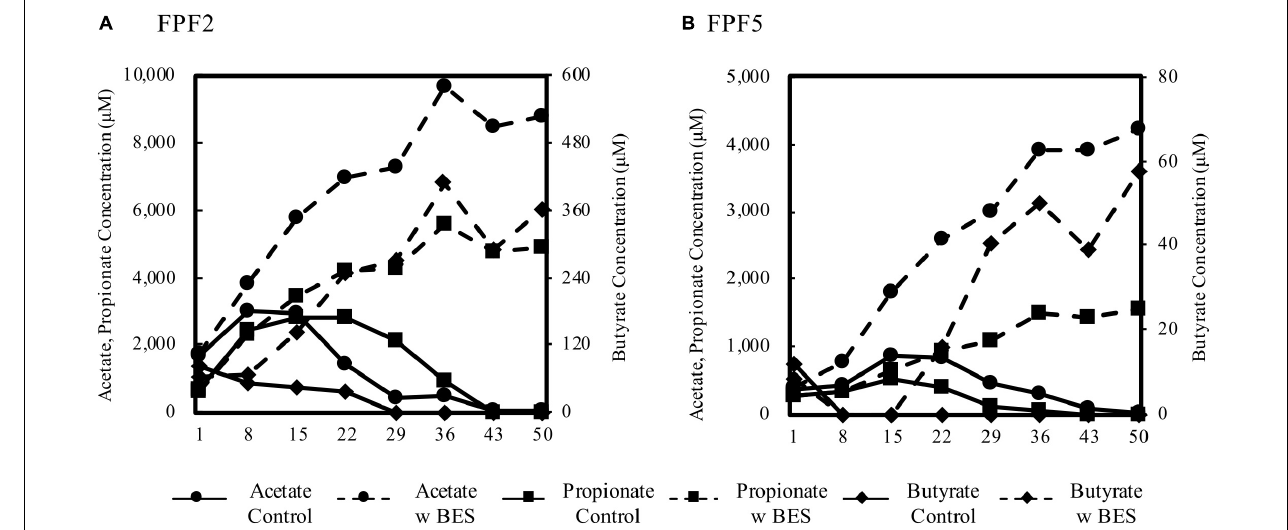
FIGURE 4 | Concentration of acetate, propionate, and butyrate over 50 days in peat slurry incubations from FPF2 (A) and FPF5 (B) . Solid lines represent no-amendment controls and dashed lined represent incubations to which BES was added to inhibit methanogens. Acetate and propionate concentrations are displayed on the left y-axis and butyrate is displayed on the right. Note the difference in y-axis scales between subplots (A) and (B)